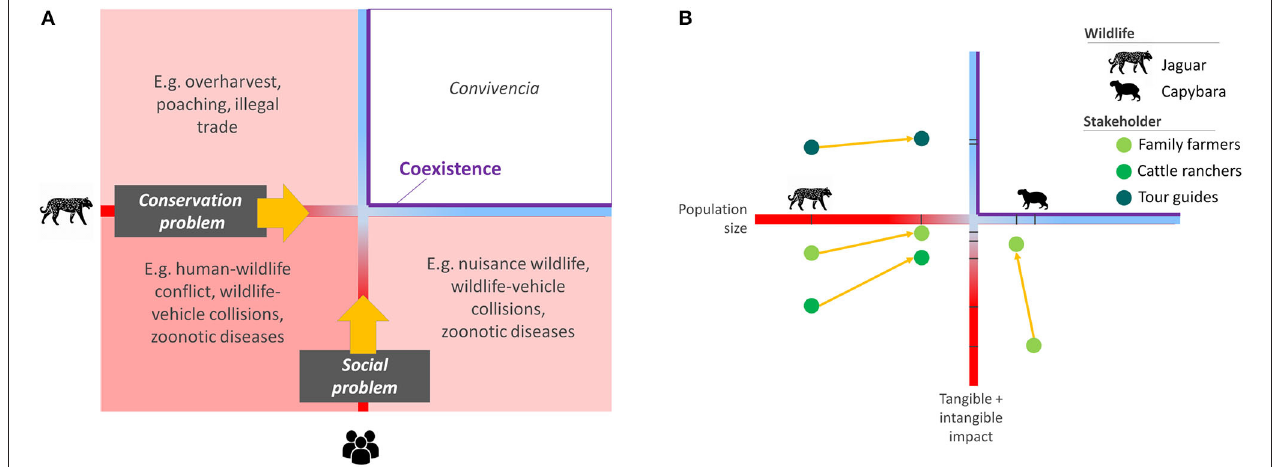
FIGURE 1 | Conceptual framework for describing human-wildlife interactions based on wildlife and human situations separately. (A) Situation ranges from poor (red) to good (blue). Parameters for wildlife and human situation are chosen according to relevance and accessibility (e.g., species population size and perceived impact, respectively). Arrows inform the direction of desired change from the conservation and social perspectives. Coexistence is defined as the condition whereby none of the parties involved–wildlife and humans–receives a significant negative impact from the other (purple line), so that their “existing together” can be sustained; (B) Hypothetical use of the framework to set goals and communicate current and desired situation in planning for multi-species (e.g., jaguar and capybara) and multi-stakeholder (e.g., family farmers, cattle ranchers and tour guides) coexistence. In this hypothetical but realistic example, the objective is to improve the situation of the parties involved toward coexistence, while recognizing that coexistence will not be fully achieved with available resources (e.g., time).